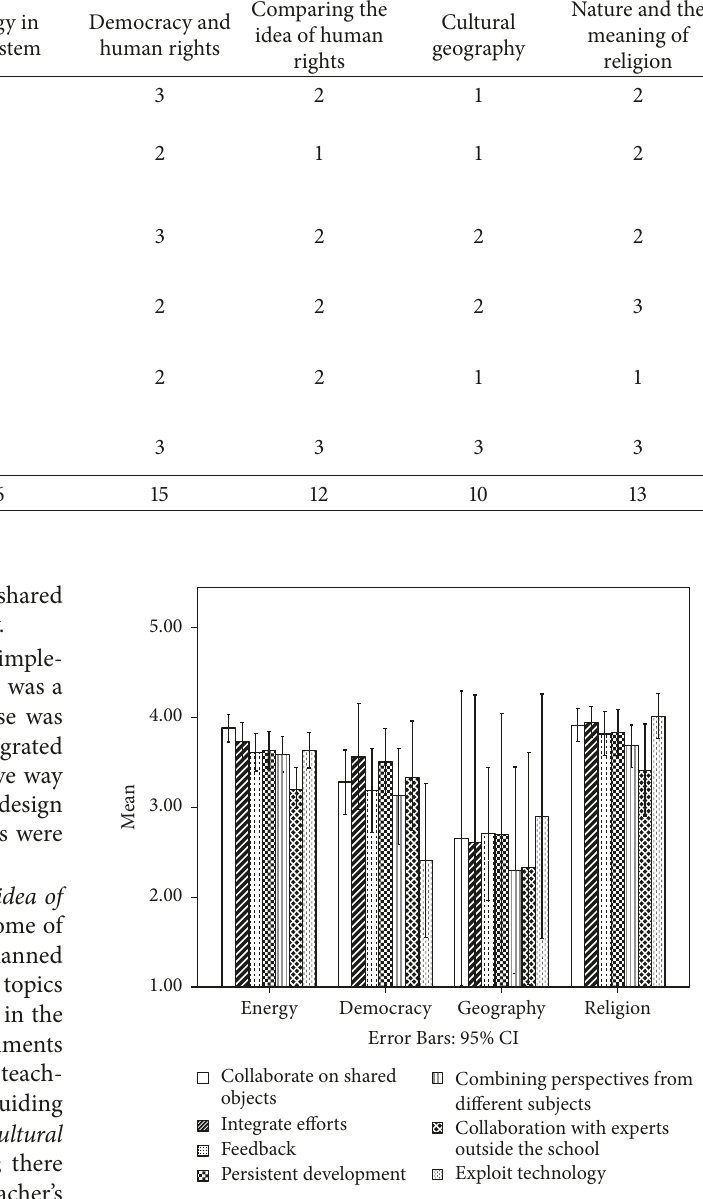
Figure1:Students’self-evaluationofthecompetencieslearntduring the